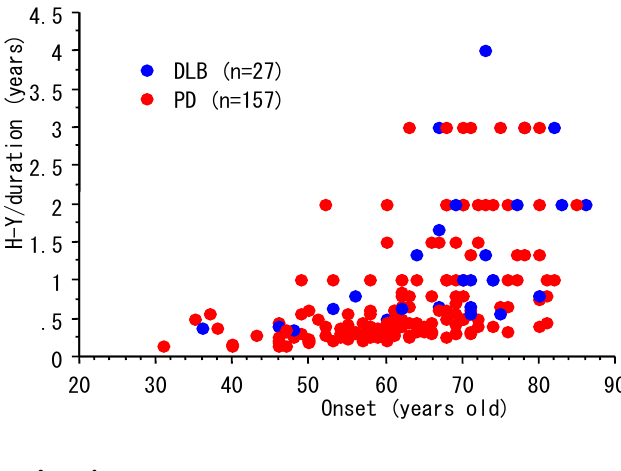
Figure 2. Disease progression and age-of-onset of Parkinson’s